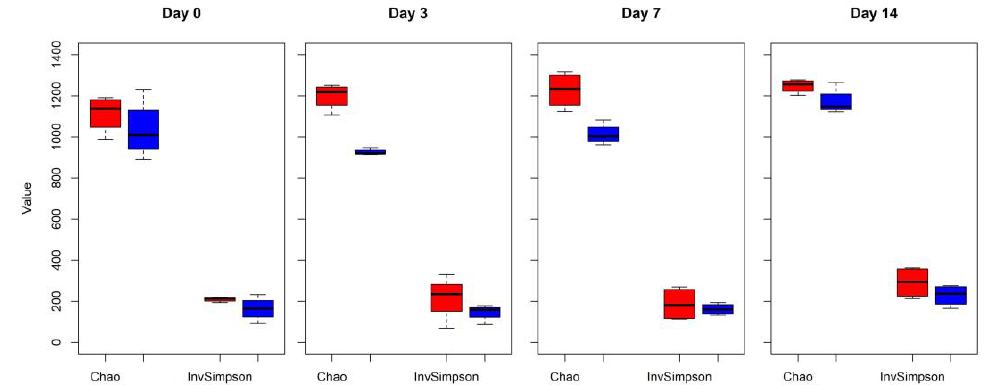
Figure 1. The microbial community alpha richness diversity (Chao and InvSimpson indexes) in cattle feces comparing control (CONT, red) versus antibiotic treatment (TREAT, blue) samples collected on 0, 3, 7, and 14